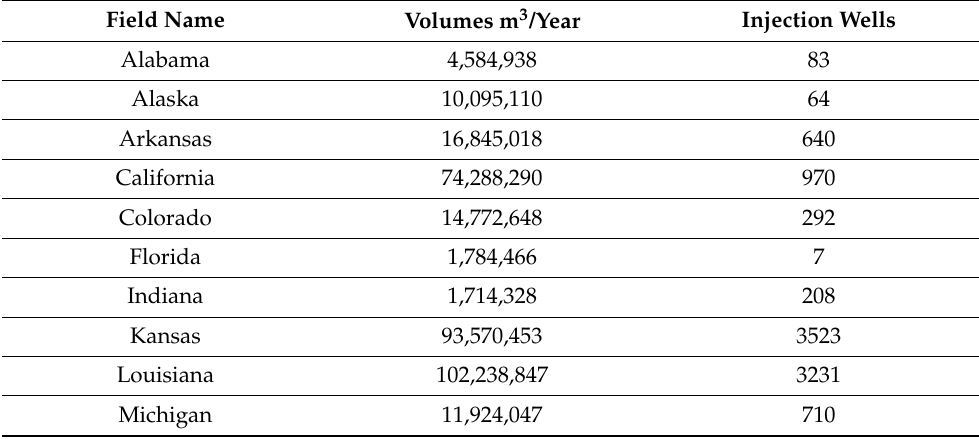
Table 1. Produced Water Volumes and Number of Injection Wells for Regions in the United States in 2012, Modified From